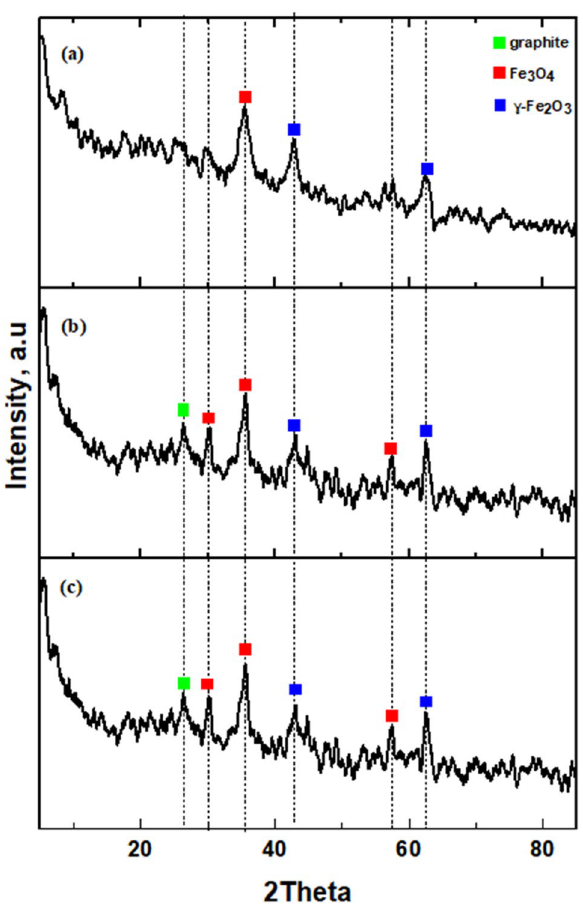
Figure 3. X-ray diffraction patterns of ( a ) MNC10, ( b ) MNC15, and ( c )